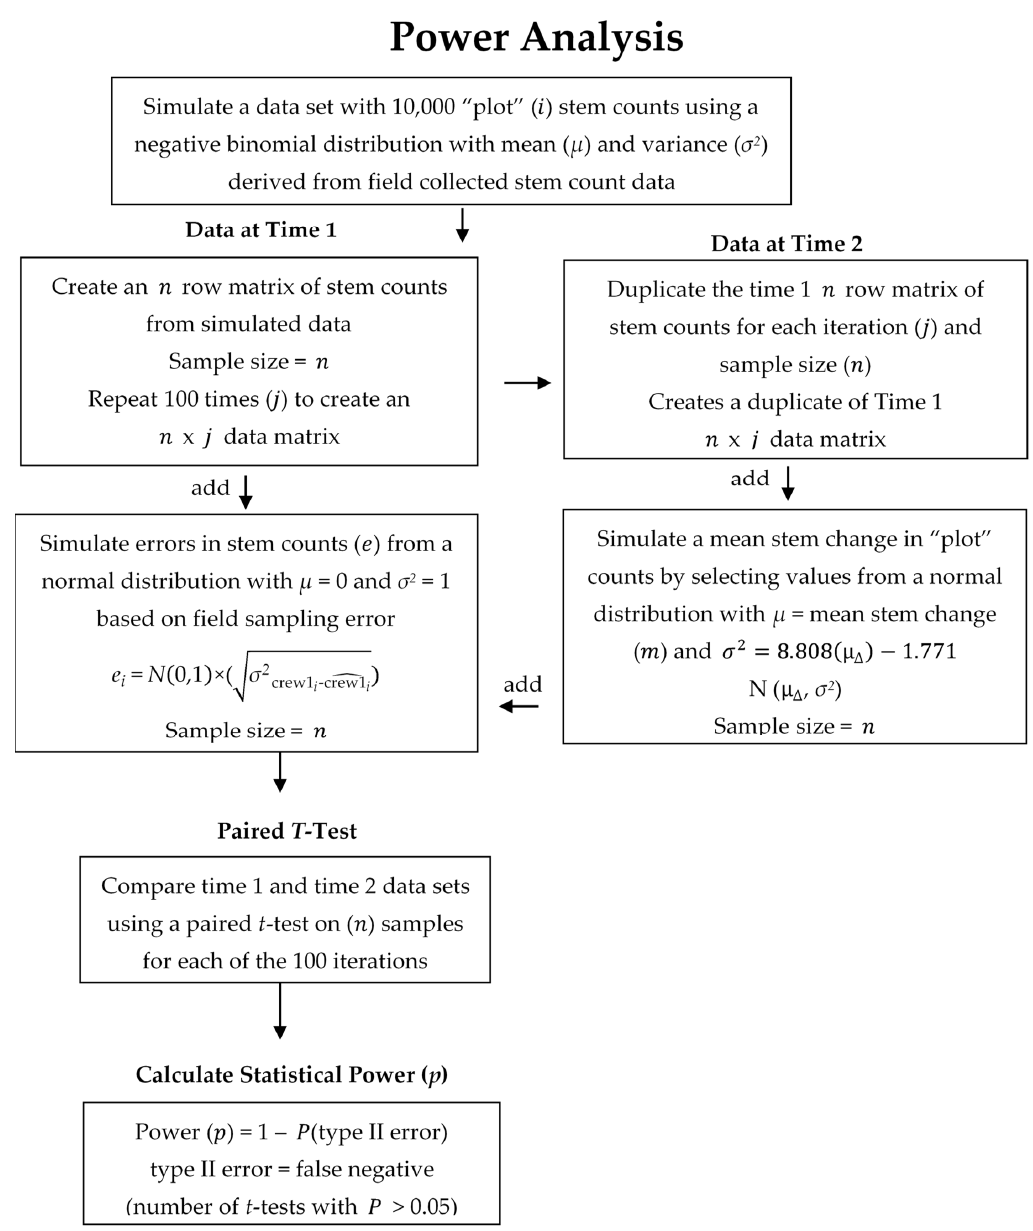
Figure 1. Illustration of all power analysis steps including simulations of each sample size ( n = 20, 30, 40, 50, 60, 70, 80, 90, 100) and mean stem change ( m = 0, 0.5, 1.0, 1.5, 2.0) scenario, beginning with data simulation and proceeding to all other steps in order following diagram arrows. All sample size and mean stem change scenarios were replicated 100 times to calculate a mean level of power for each